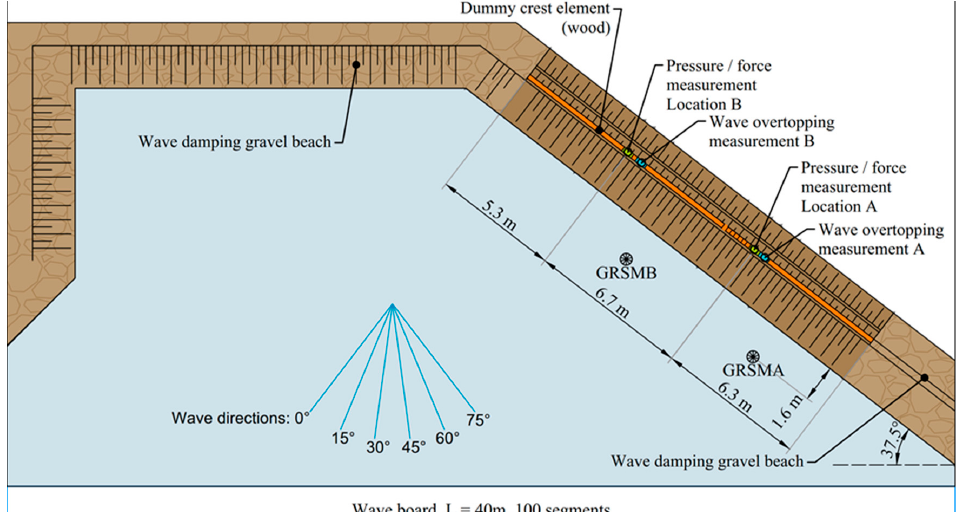
Figure 1. Tests set-up in the wave basin [5].